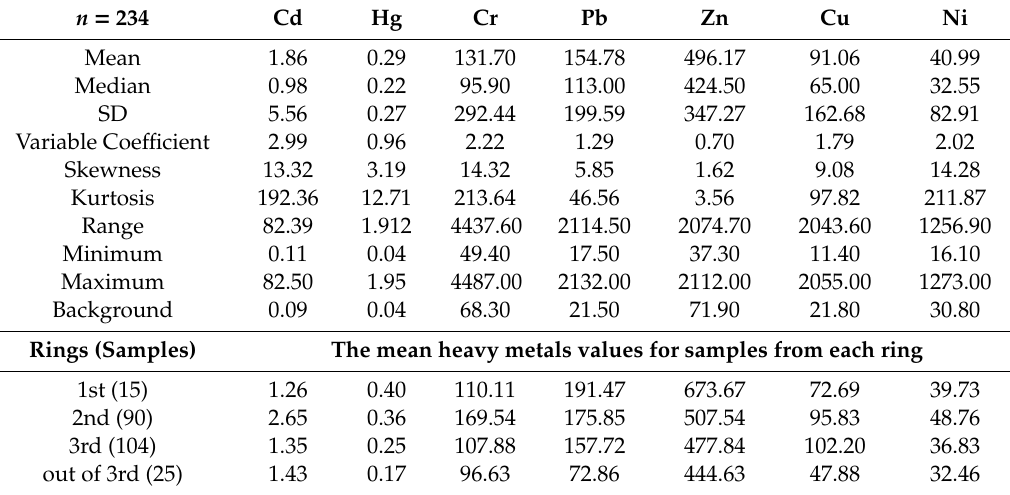
Table 2. Statistical analyses of Shijiazhuang street dust heavy metal content (unit: mg / kg). n = 234 Cd